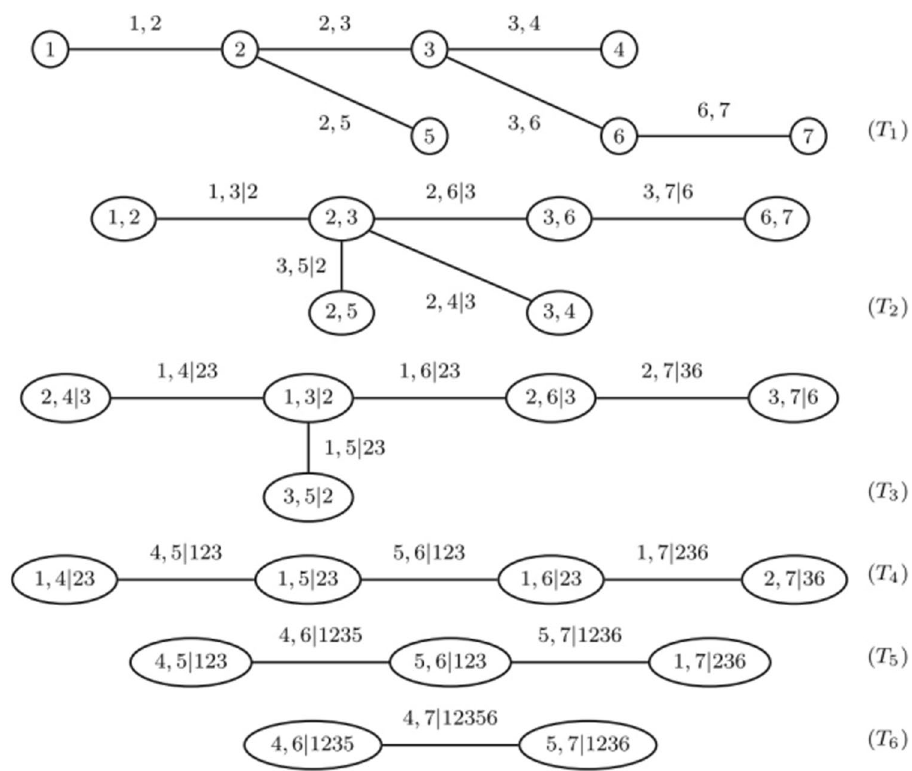
Fig. 2 A sample of the seven- dimensional R-Vine copula (Dißmanna et al.